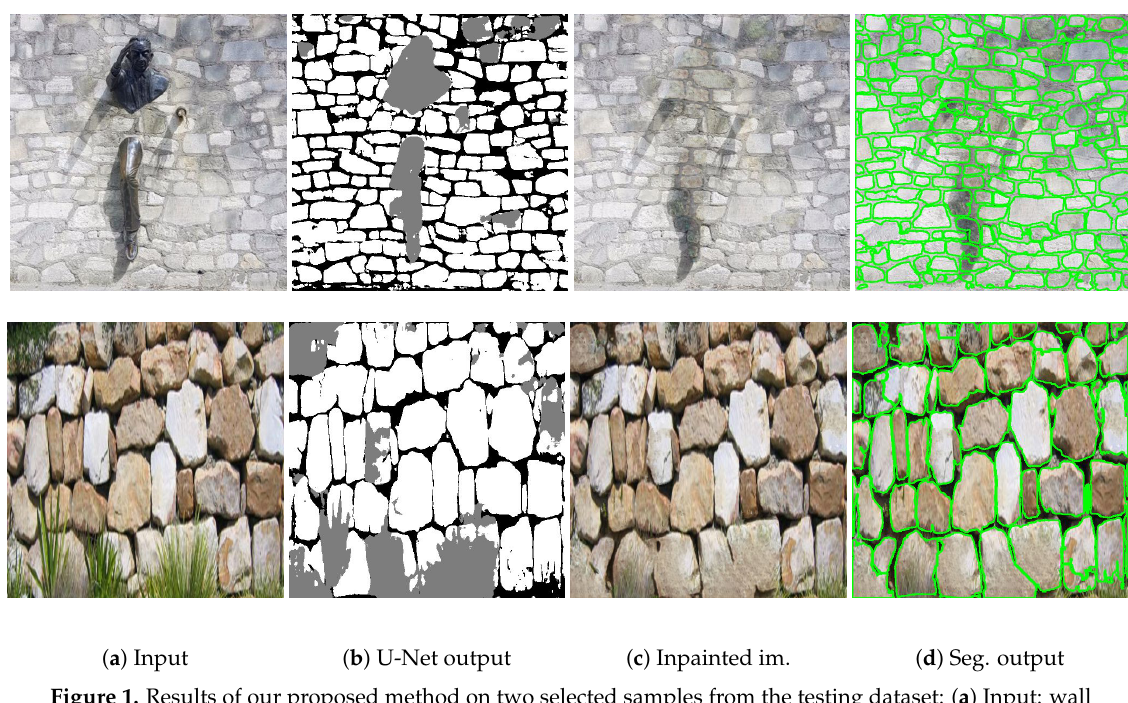
Figure 1. Results of our proposed method on two selected samples from the testing dataset: ( a ) Input: wall image occluded by irregular objects ( b ) Result of preliminary brick-mortar-occluded region separation ( c ) Generated inpainted image ( d ) Final segmentation result for the inpainted